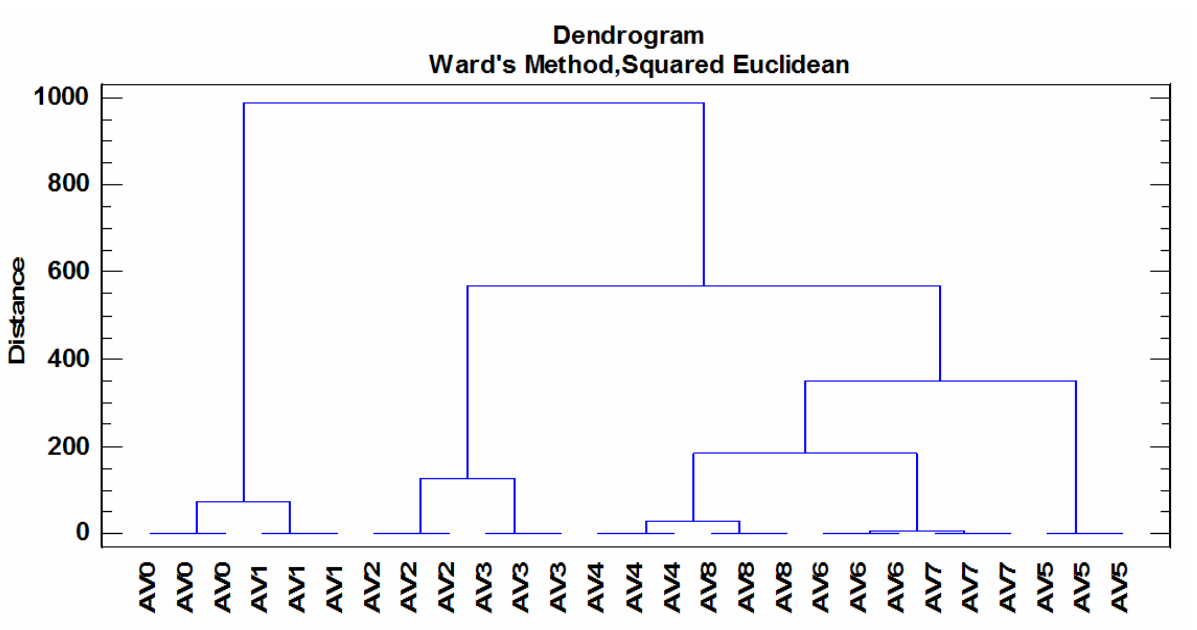
Fig. 3. Cluster analysis of wines fermented with different yeast strains